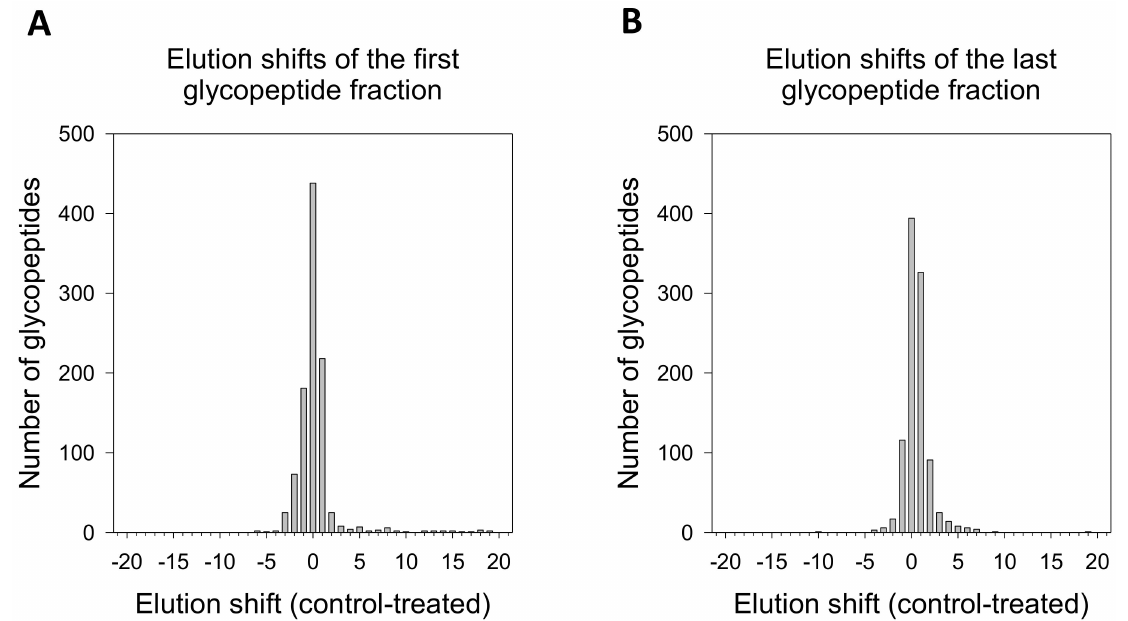
Figure 3. Global analysis of glycopeptide elution shift due to treatment-induced glycosylation. The shift was separately calculated for each glycopeptide. The first ( A ) and last ( B ) glycopeptide fractions are the first and last fractions in which the analysed glycopeptide was